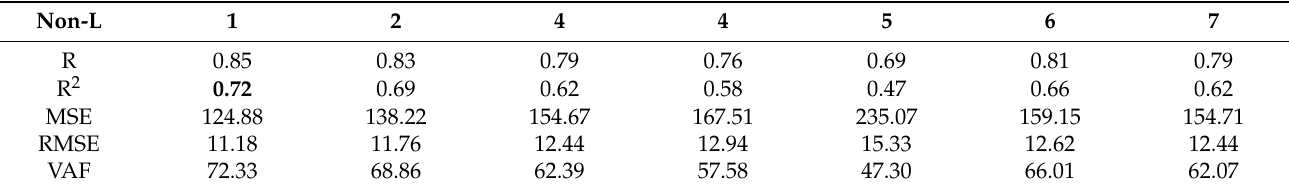
Table 8. Summary of non ‐ linear multi ‐ variable statistical analysis of CLI.